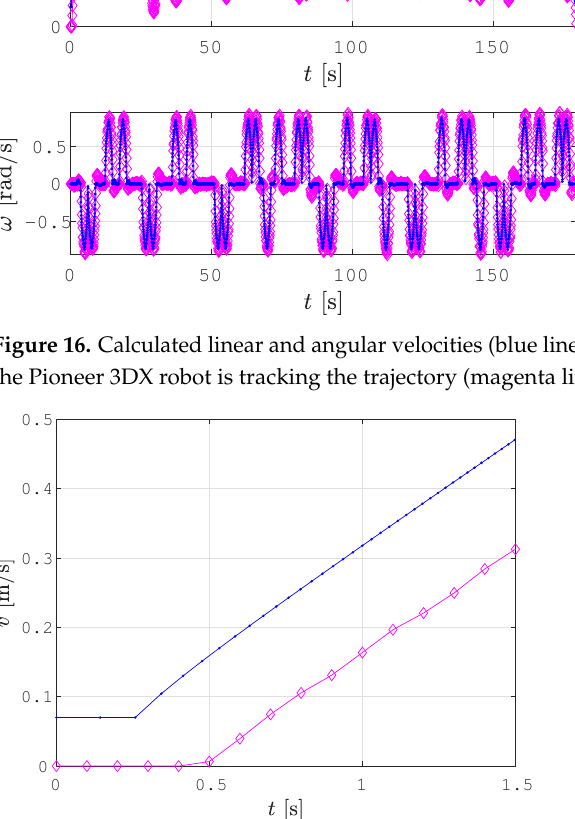
Figure 17. Real linear velocity, while the robot Pioneer 3DX is following the trajectory (magenta line), deviates from the applied linear velocity (blue line).